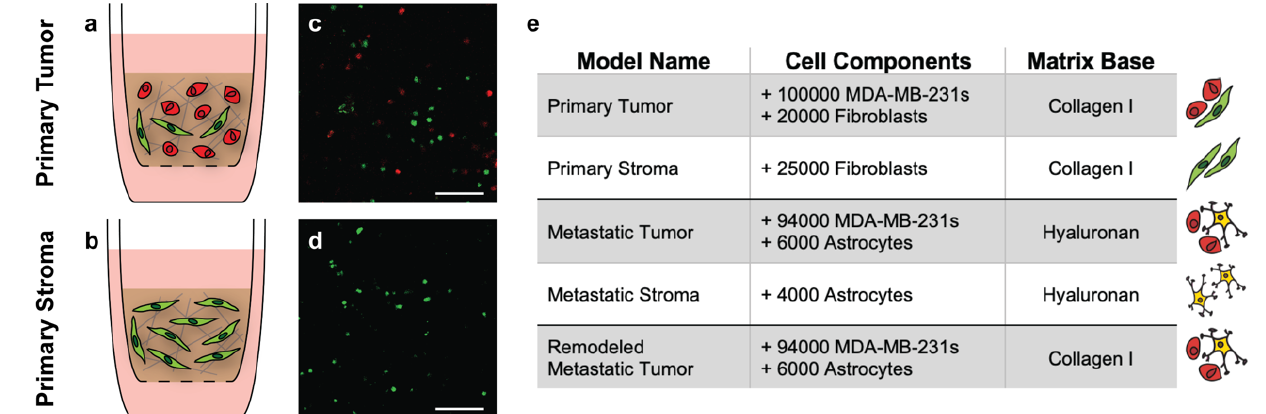
Figure 4. Tissue-engineered model parameters. Graphical depictions of the primary tumor and stroma models indicate the cellular and matrix components within each ( a , b ). Representative cross- sectional images of the models 18 h after formation show successful incorporation of labeled fibro- blasts (green) and MDA-MB-231 breast cancer cells (red) ( c , d ). Scale bars = 200 μm. Summary of the cell components and matrix base for each of the corresponding tissue-engineered models ( e ).